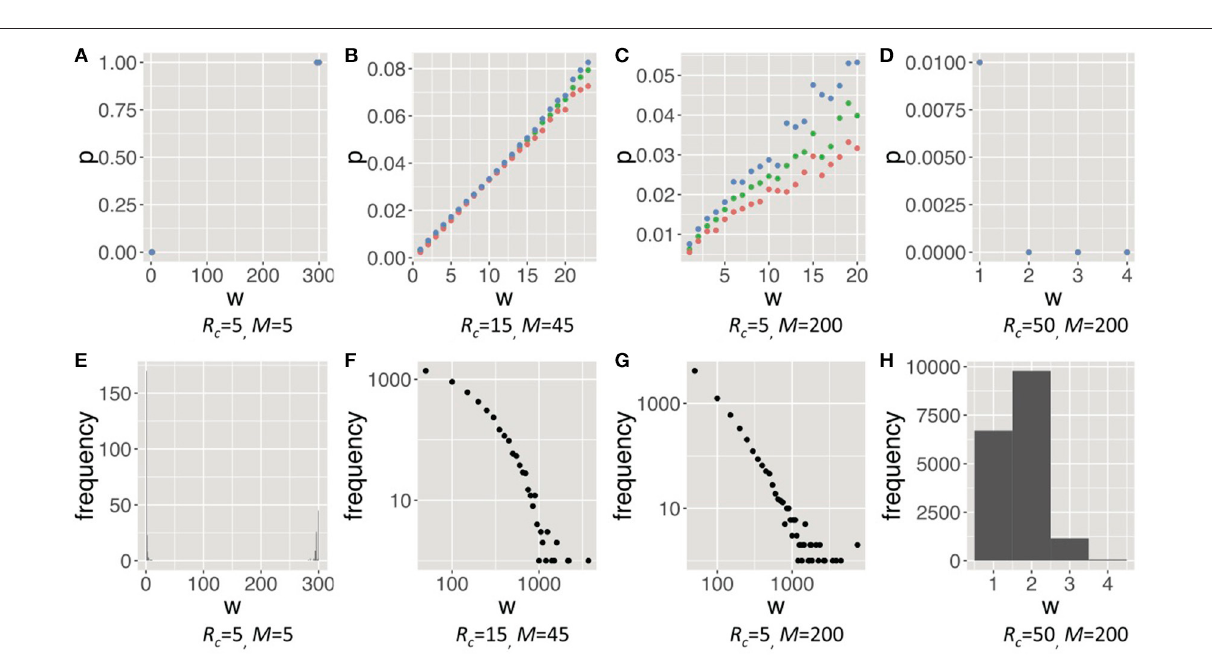
FIGURE 6 | Strategies of social grooming (A–D) , i.e., probability p of social grooming after each strength of social relationship w , and social structures of each trend (E–H) , i.e., distribution of w in each trend ( R g = 300). These figures show trend 1, 2, 3, and 4 from left. These trends in R g = 100 are similar to them (see Figure S4). In (A–D) , the orange points are the 25th percentile, the green points are the 50th percentile and the blue points are the 75th percentile. In the (A–D) , we drew w when the number of samples was more than 20. The figures of trend 2 and 3 of the (F,G) are shown by using a logarithmic scale in both axes. In the social structure of trend 1 (E) , many weak relationships were caused by mutation noises of q